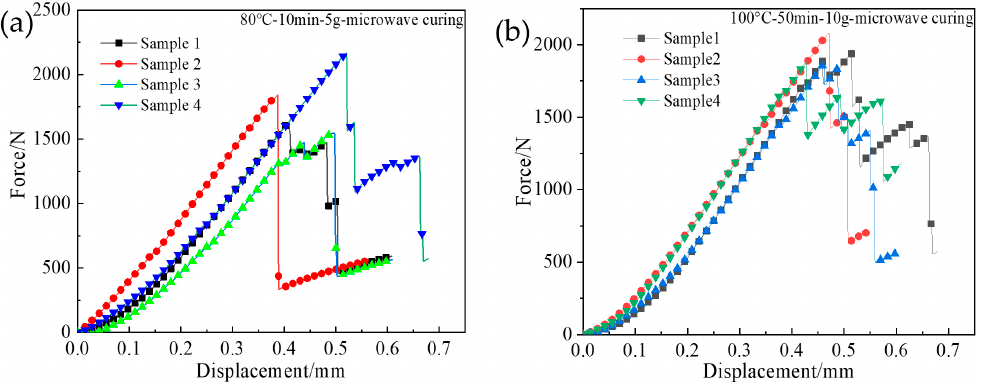
Figure 4. Three ‐ point bending force–displacement curve of four specimens, ( a ) 80 °C ‐ 10 min ‐ 5 g ‐ Figure 4. Three-pointbendingforce–displacementcurveoffourspecimens, ( a ) 80 ◦ C-10 min-5 g-microwave